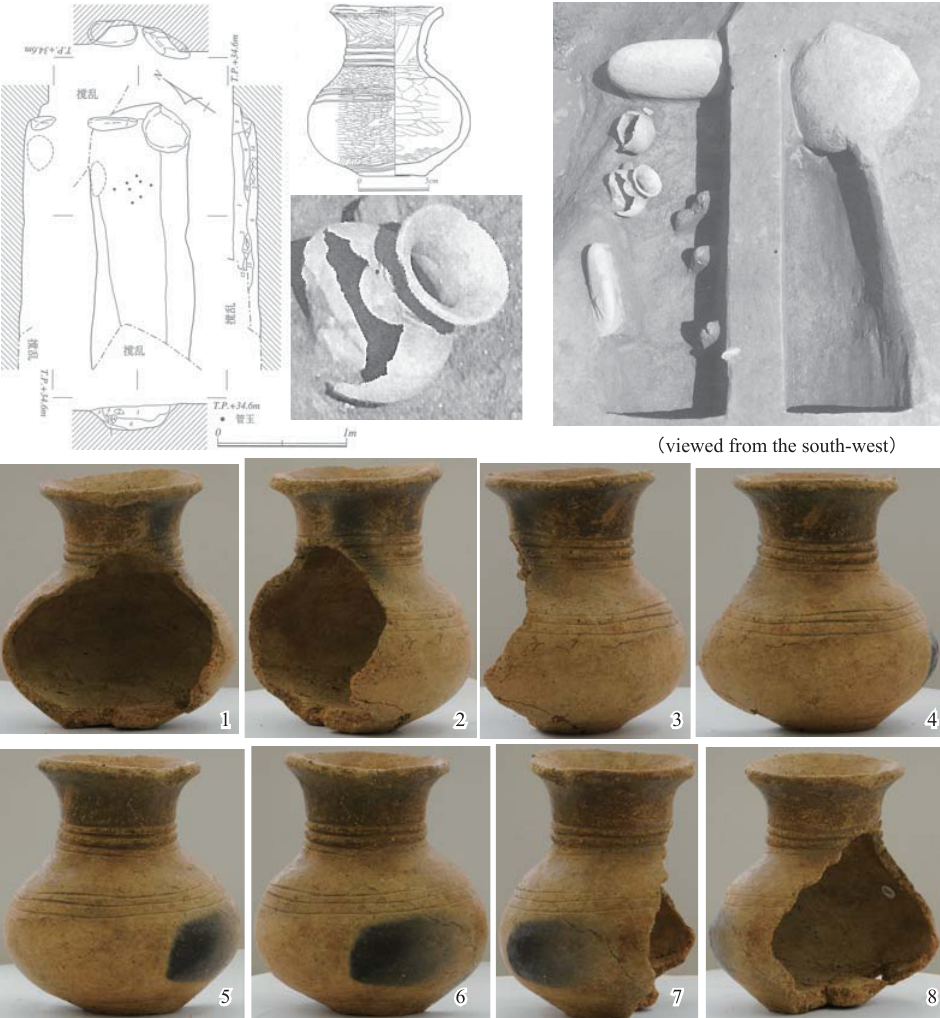
Figure 6. The offering vessel no.7 in pit-grave SK08 was found around the eastern corner in an oblique position. Given that the direction of the damaged part of its body does not correspond with the axis of the later disturbing trench, it must have been rotated counterclockwise slightly by the force of that disturbance from the eastern direction, which suggests that a fire-cloud had originally been faced to the dead